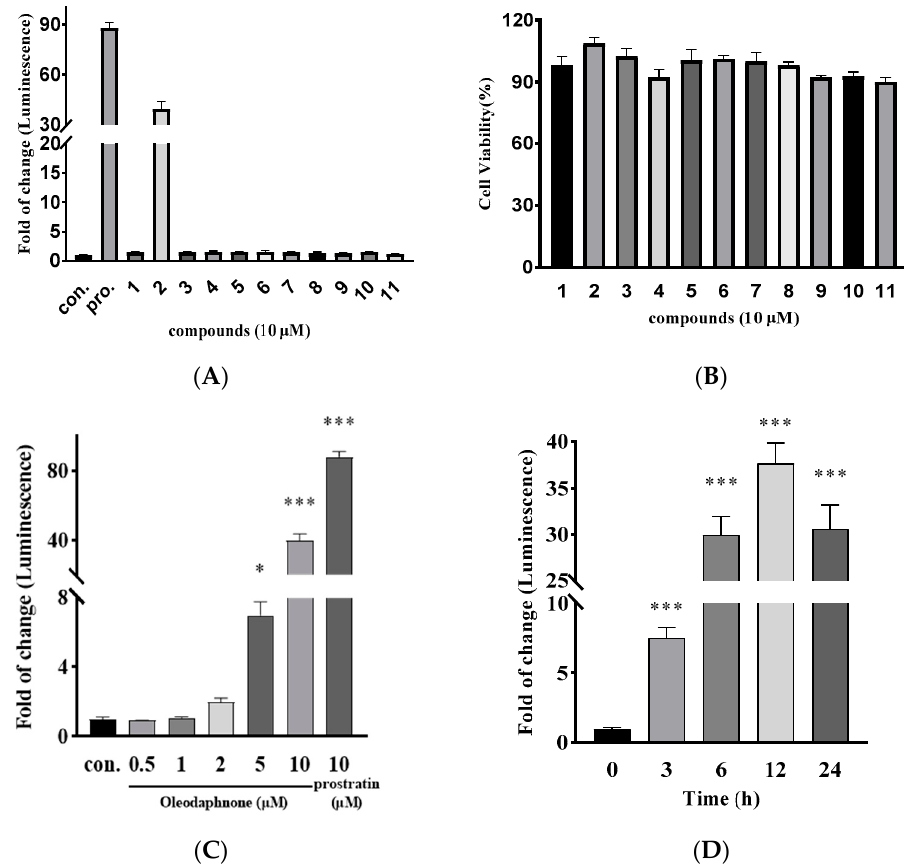
Figure 2. Characterization of oleodaphnone as an HIV latency-reversing agent. ( A ) Histogram illustrating the HIV latency reversal profiles of NH2 cells screened with 11 compounds from W. chamaedaphne . NH2 cells were treated with the indicated compounds for 24 h and subjected to HIV latency reversal assays. The color represented the compound. ( B ) Cytotoxicity evaluation of 11 compounds. NH2 cells were treated with 11 compounds at 10 µ M for 24 h, and subjected to in vitro cytotoxicity assays. The color represented the compound. Data are presented as mean ± SEM ( n = 3). ( C ) Dose-dependent effects of oleodaphnone on the reactivation of latent HIV. NH2 cells were treated with the indicated concentration of oleodaphnone for 24 h and subjected to HIV latency reversal assays. The color represented the dose. Data are presented as the mean ± SEM. ( n = 3, * p < 0.05, *** p < 0.001, compared with control). ( D ) Time-dependent effects of oleodaphnone on the reactivation of latent HIV. NH2 cells were treated with 10 µ M oleodaphnone for the indicated number of hours and subjected to HIV latency reversal assays. The color represented the time. Data are presented as the mean ± SEM ( n = 3, *** p < 0.001, compared with